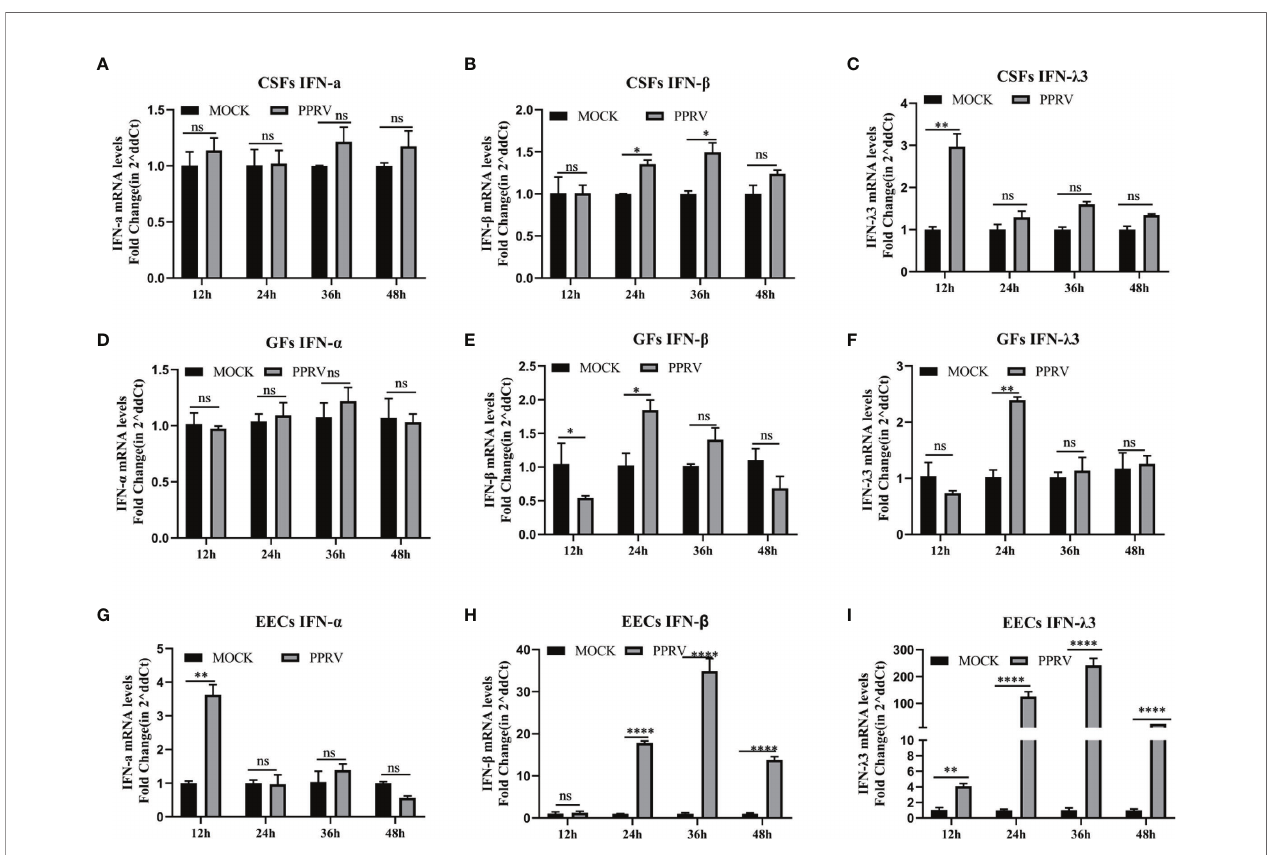
FIGURE 3 | PPRV induces innate immunity in EECs, but not CSFs and GFs. (A – C) CSFs were infected with PPRV for 12-48 h, and expression of IFN- a , IFN- b , and IFN- l 3 was measured by RT-PCR. (D – F) GFs were infected with PPRV for 12-48 h, and expression of IFN- a , IFN- b , and IFN- l 3 was measured by RT-PCR. (G – I) EECs were infected with PPRV for 12-48 h, and expression of IFN- a , IFN- b , and IFN- l 3 was measured by RT-PCR. Comparisons between groups were calculated using two-way ANOVA in GraphPad Prism 8. * P < 0.05; ** P < 0.01; *** P < 0.001; **** P < 0.0001; ns, no signi fi cant